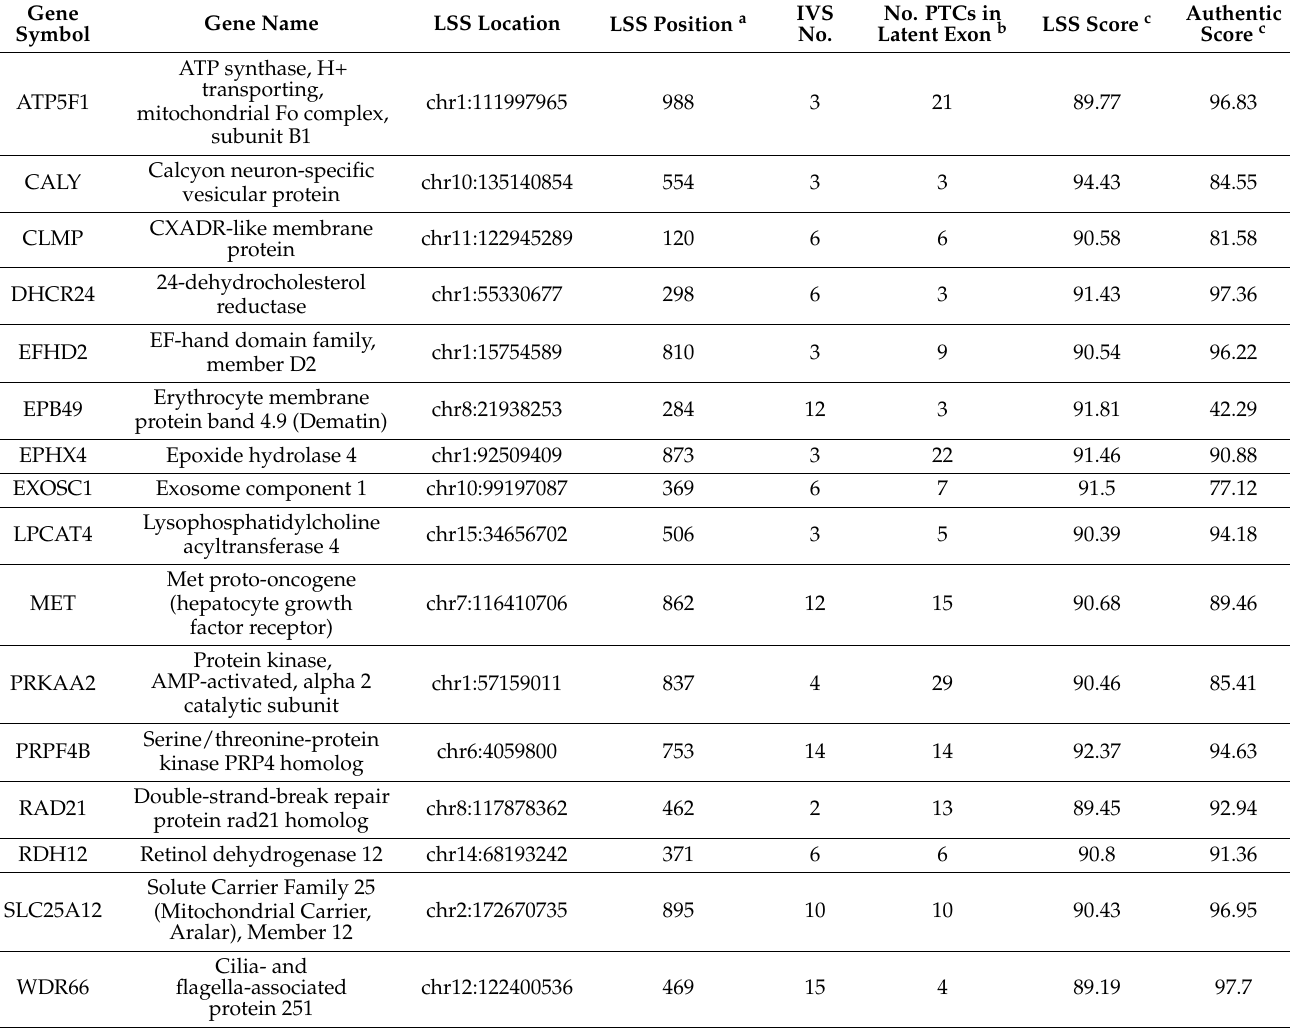
Table 1. Gene transcripts with activated LSS in breast cancer cells and